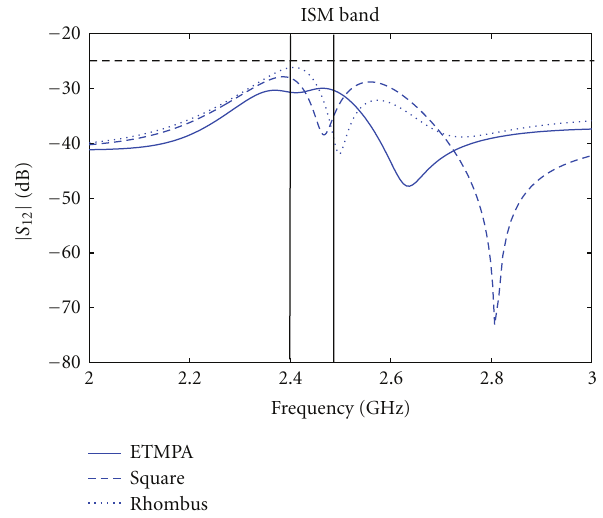
Figure 6: Simulated mutual coupling between the first and second port of the ULA array: tip-truncated ETMPA (full line), square ring patch (dashed line), and rhomboidal ring patch (dotted and dashed line).